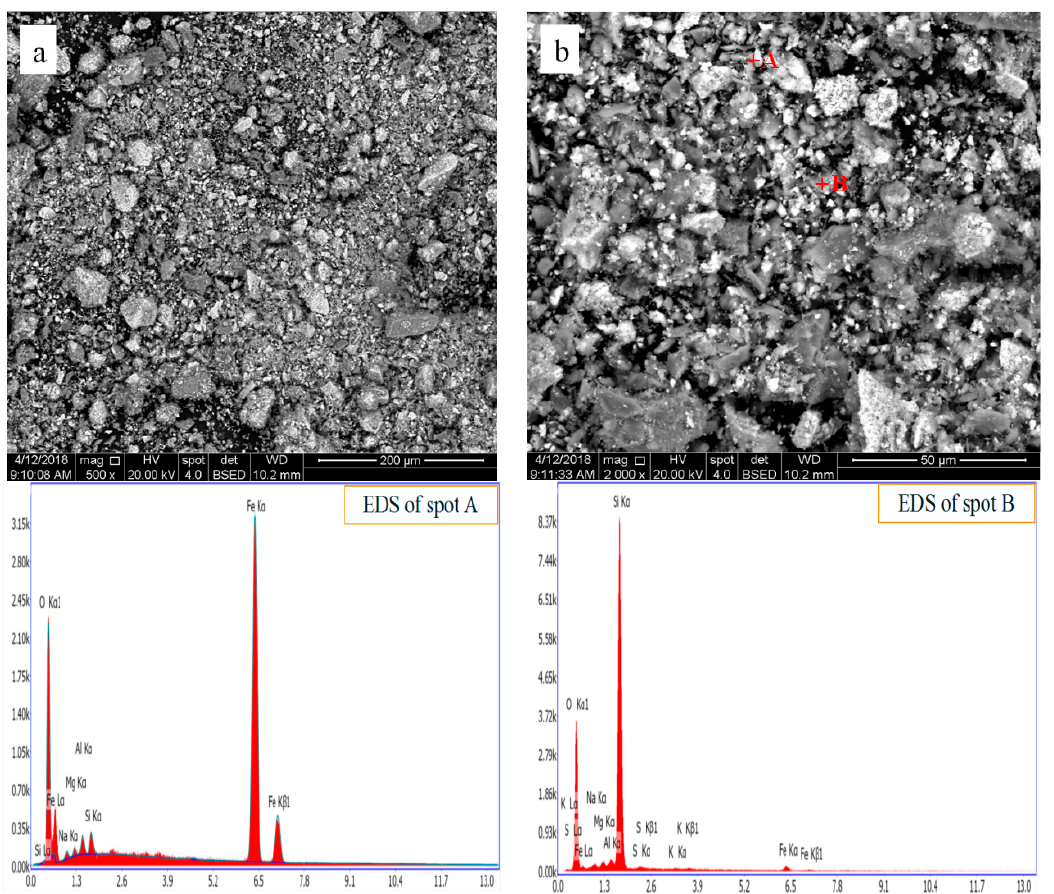
Figure 2. SEM images and corresponding EDS pattern of cyanidation tailing. ( a ): low magnification image; ( b ): magnified image of local area in ( a ).